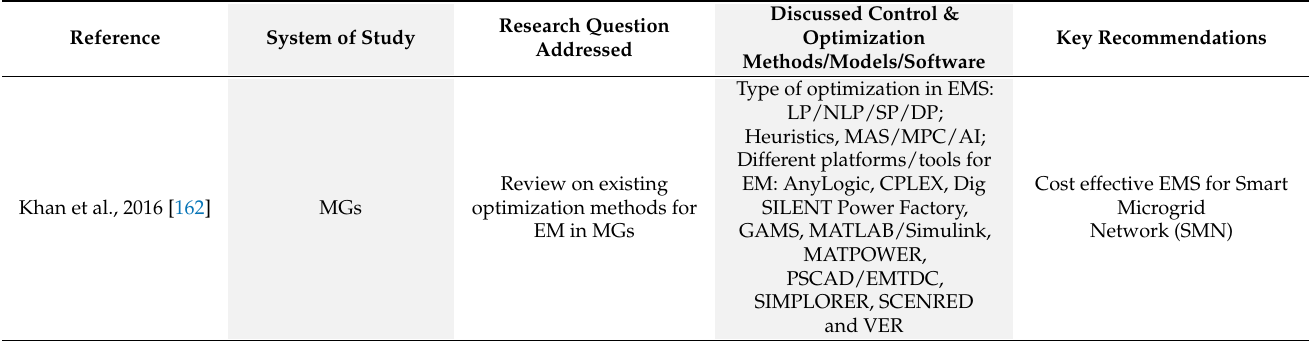
Table Legend: (C = Centralized, D = Decentralized, Di = Distributed, Hy = Hybrid, H = Hierarchical) (SO = Stochas- tic Optimization; RO = Robust Optimization, IA = Intelligent Algorithms (AI-based), heuristics, GA =